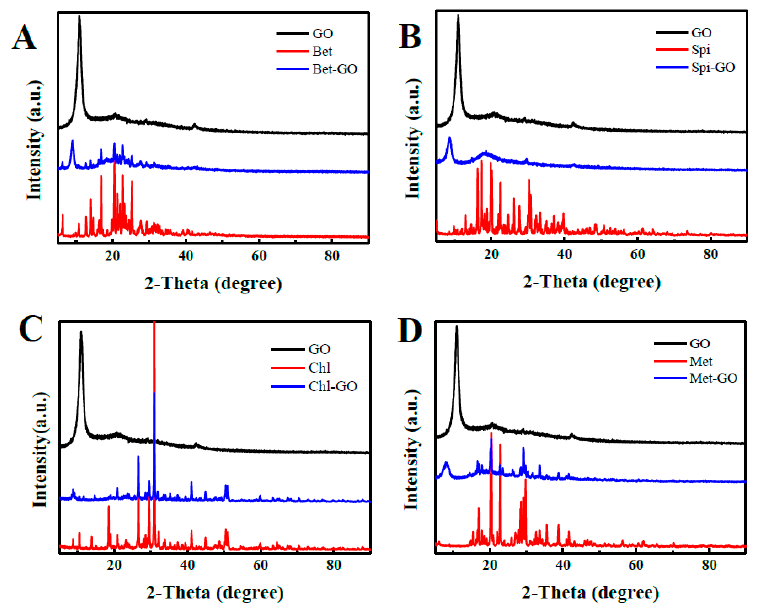
Figure 3. XRD curves of GO and pesticide-GO nanocomposites, Bet and Bet-GO (1:9) ( A ), Spi and Spi-GO (3:7) ( B ), Chl and Chl-GO (5:5) ( C ), Met and Met-GO (3:7) ( D ).